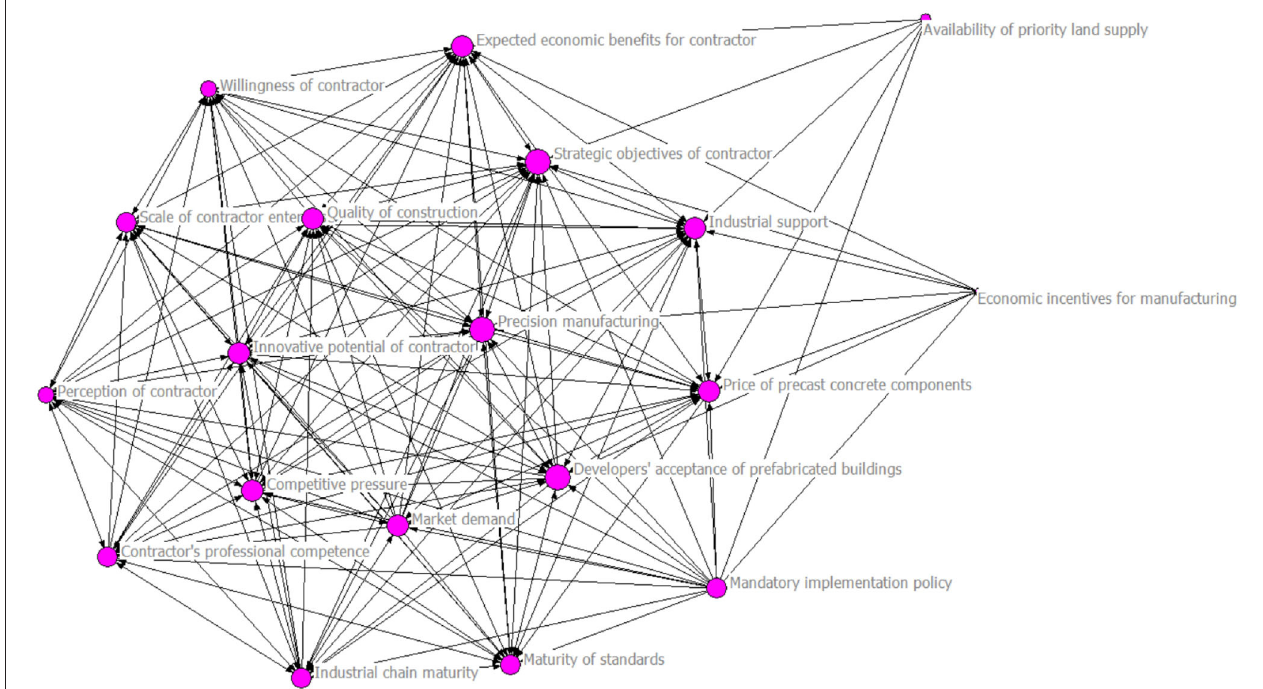
FIGURE 2 | Visual model for influencing factors that affect the degree centrality result.